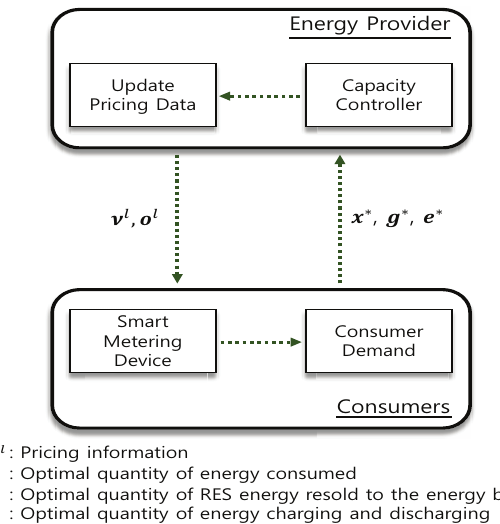
Figure 2. Interactions between the energy provider and